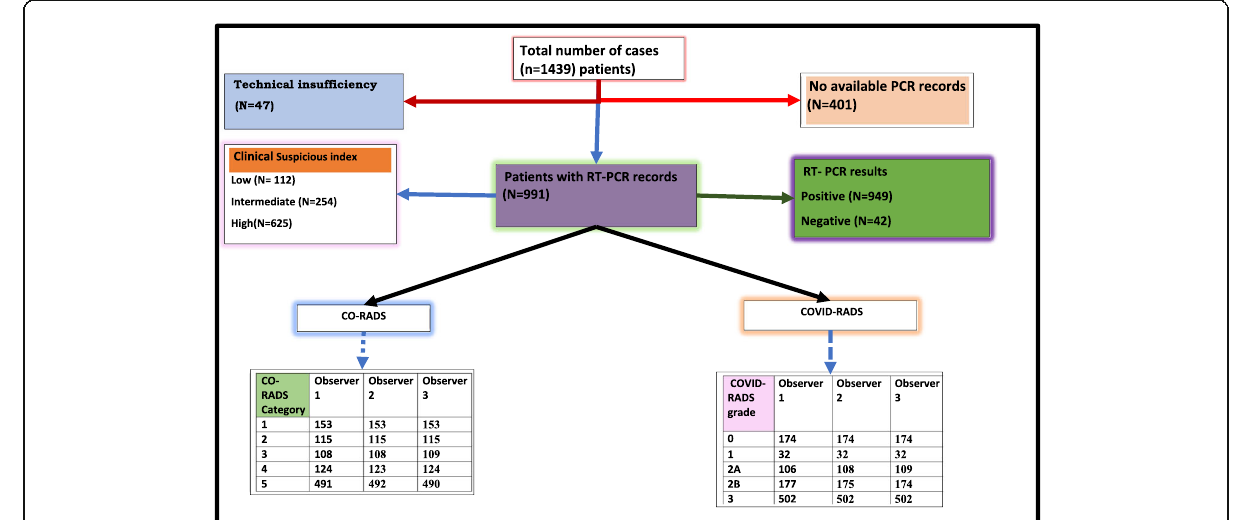
Fig. 1 CONSORT participant flow